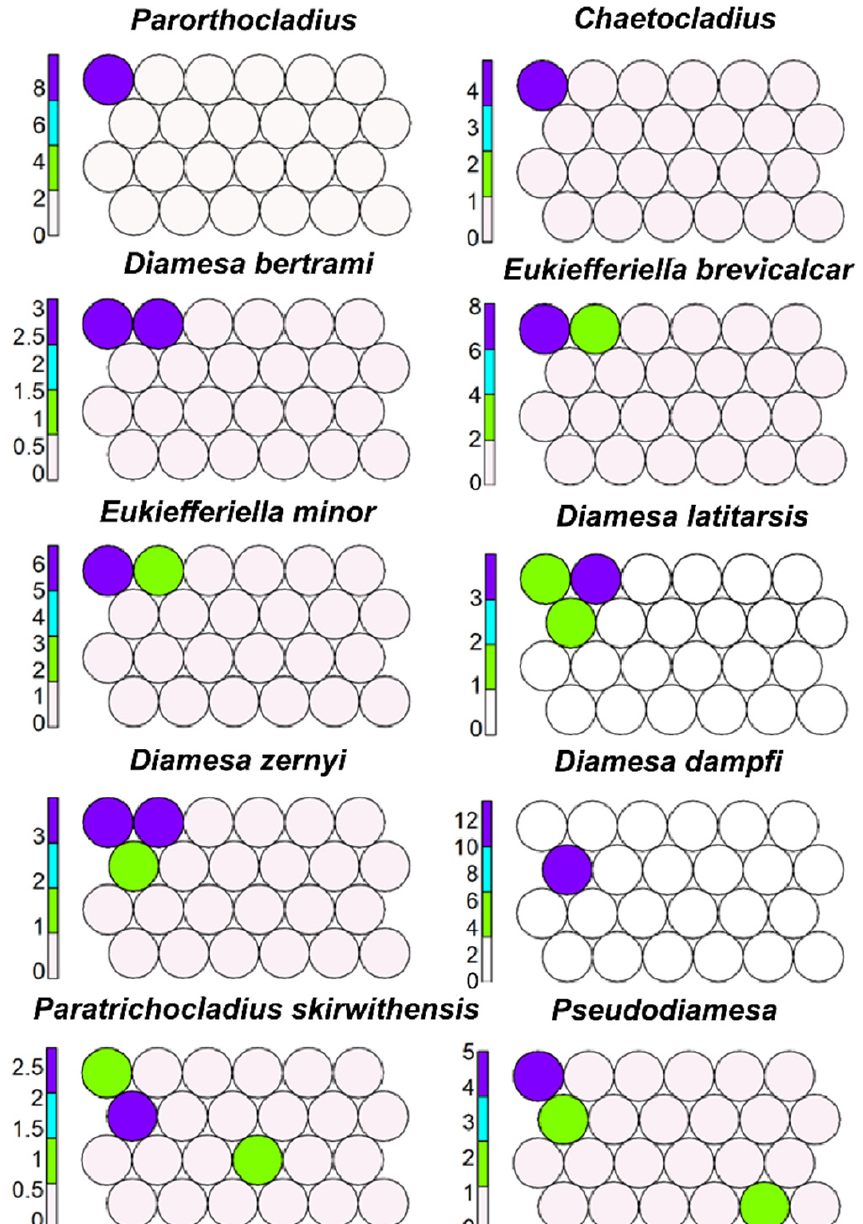
Figure 2. Unsupervised map of ten morphotaxa characterizing kryal and cold krenal; the codes and the species associated to morphotaxa are in Supplementary Materials S1 and S2. Krenophilous morphotaxa, such as B. bifida and B. longifurca , Micropsectra atrofasciata, and Thienemanniella , were scattered in several cells (10, 14–16, 21–23) but were mostly in cells 14 and 22 (Figure